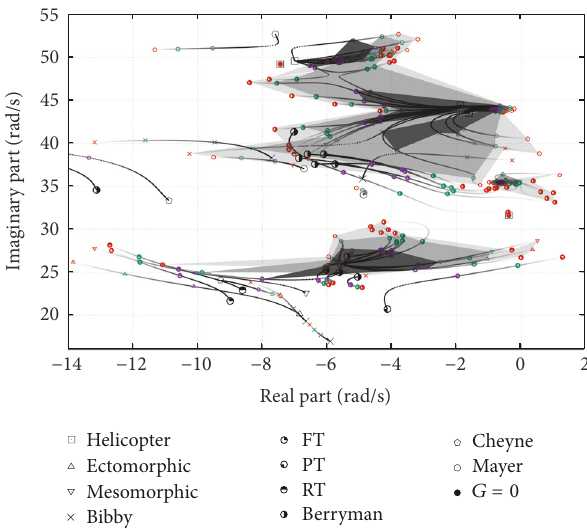
Figure 6: Collective control pilot-in-the-loop root loci, for gearing ratio increase. The area delimited by dashed rectangle is that represented in Figure 7.